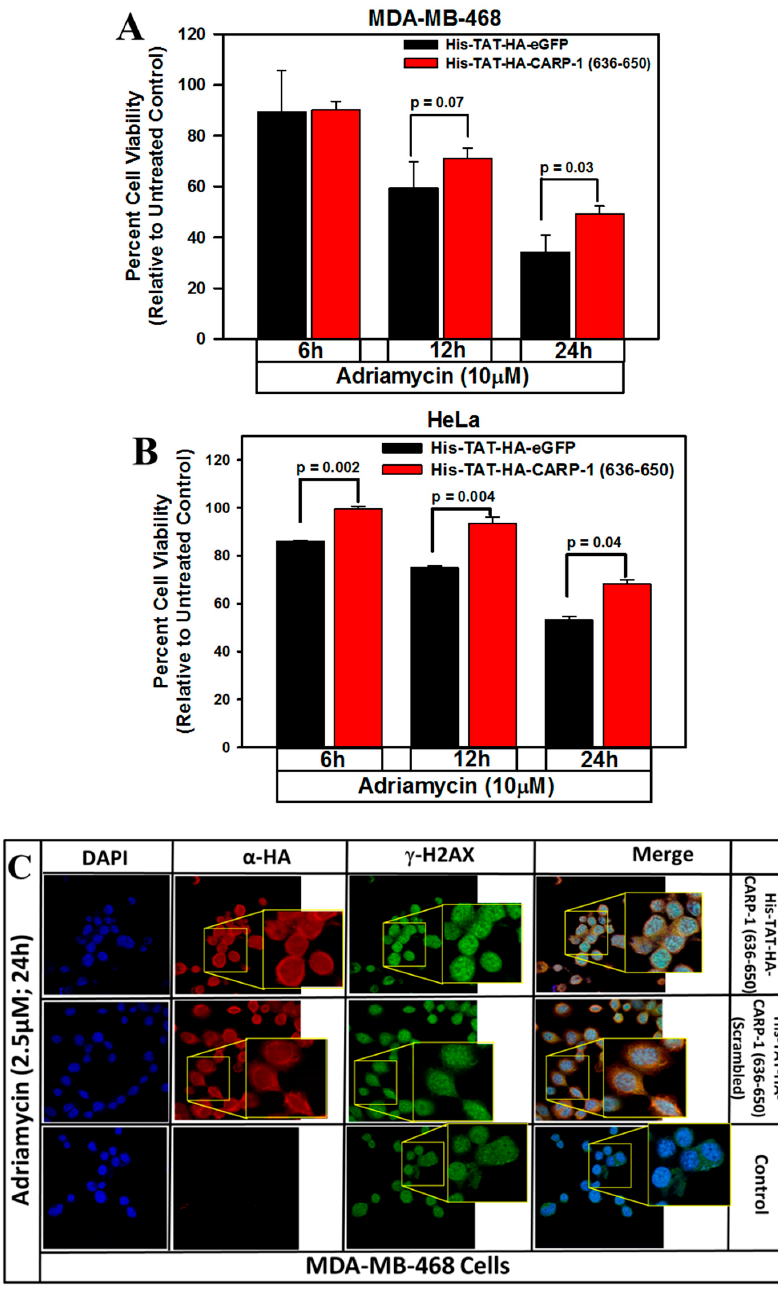
Figure 8. Ectopic expression of TAT-CARP-1 (636–650) peptide results in enhanced viabilities of Adriamycin-treated cells. MDA-MB-468 ( A ) or HeLa ( B) cells were pre-incubated with 300 μ g/mL indicated peptides for 72 h, followed by treatments with the noted dose and time of Adriamycin. Determination of viable/live cells was carried out using an MTT assay as described in Section 2. The bar charts in panels A and B represent means of three and two independent experiments, respectively; bars, SE. ( C ) Indicated cells were either pre-incubated with 6 μ g/mL indicated peptides for 72 h or not (Control), followed by treatments with Adriamycin as noted. Cells were then processed for immunofluorescence staining for TAT-CARP-1 peptide (red), γ H2AX (green), and DAPI (blue) as detailed in Section 2 and Figure S3 (Supplementary Materials). Insets in C show enlarged areas of respective photomicrographs to indicate presence of TAT-CARP-1 peptide and γ H2AX in respective columns. The insets in the top and middle rows of the merge column show co-localization of TAT-CARP-1 peptide, and γ H2AX (magnification: 250×).